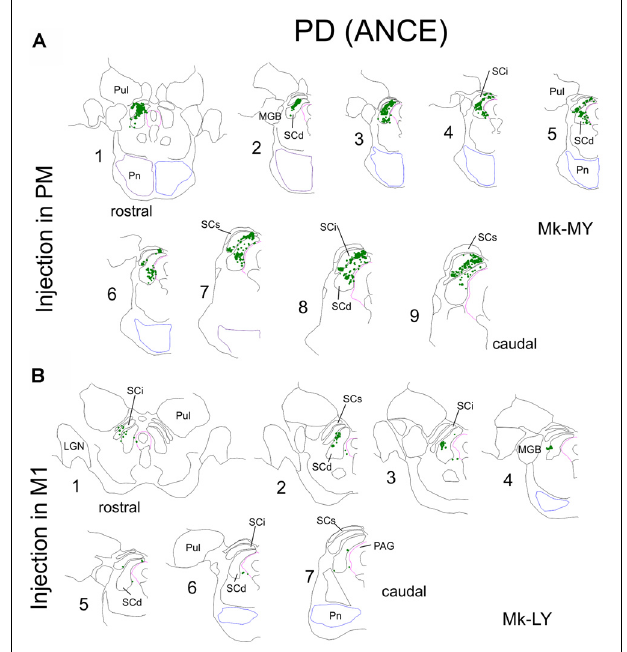
FIGURE 2 | Same as in Figure 1 , but for two representative Parkinson’s disease (PD) monkeys. Note that one monkey (Mk-MY, A ) was injected with BDA in PM, whereas the injection was in M1 in the second monkey (Mk-LY, B